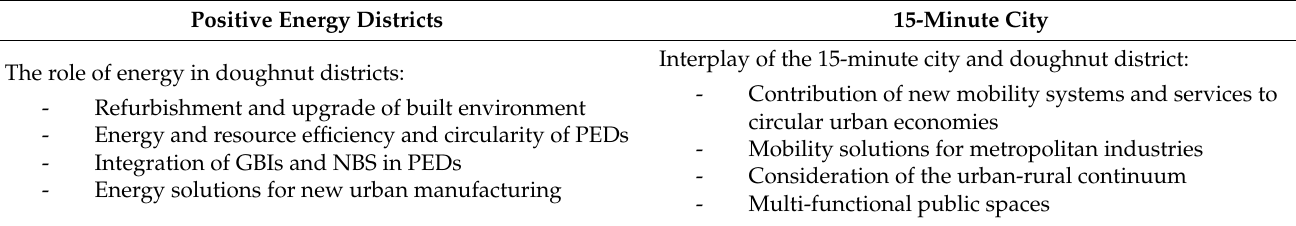
Table 5. Interface of the Downsizing District Doughnuts with the other two DUT pillars.